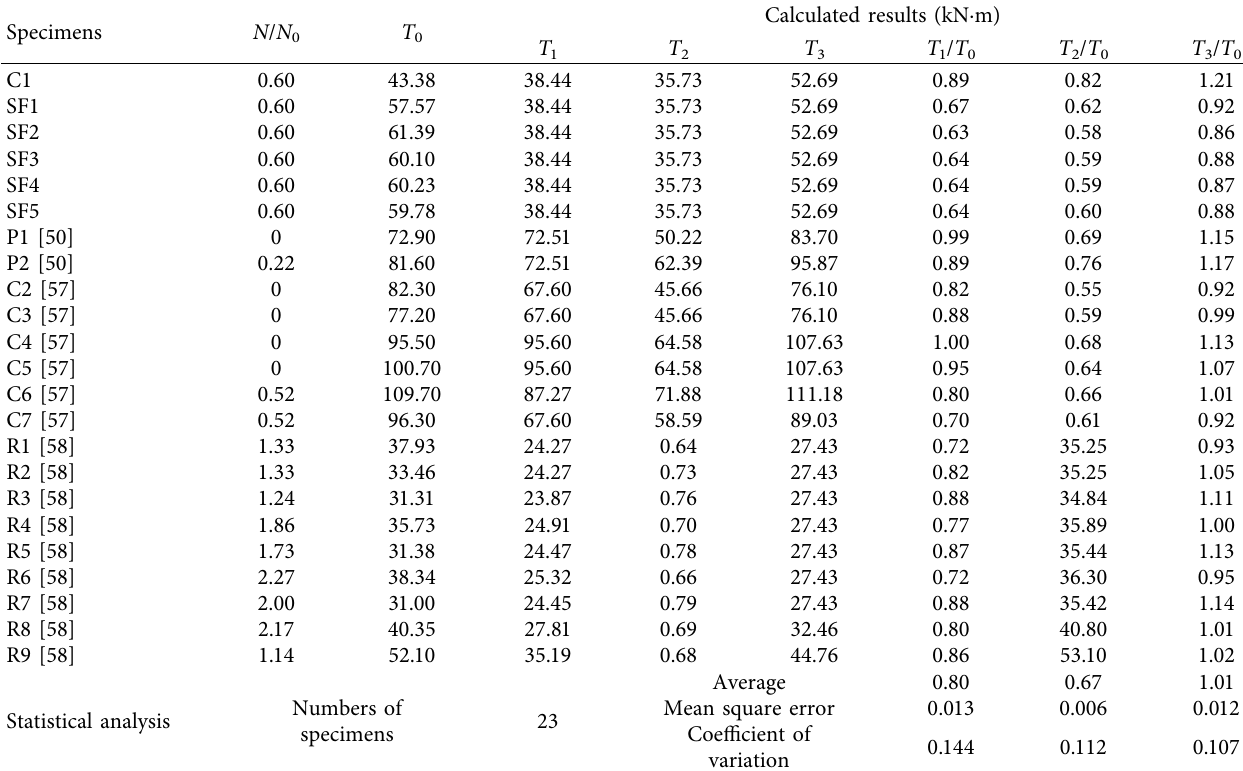
Table 9: Comparison of calculation methods of torsion bearing capacity (kN ·